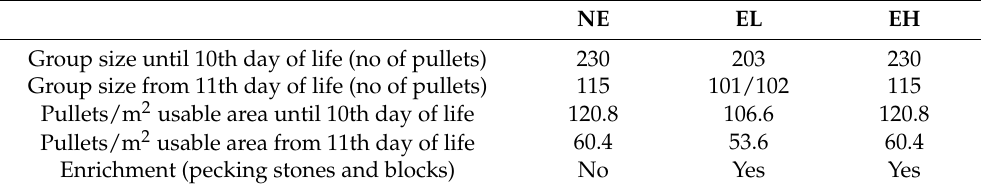
Table 1. Overview of the experimental groups NE (not enriched), EL (enriched, low stocking rate) and EH (enriched, high stocking rate): Stocking rates, enrichment, and group sizes. Half of each EG was placed in another compartment of the aviary on the 10th day of life, hence the reduced stocking rates from the 11th day of life onwards. Enrichment: Pecking stones and pecking blocks. NE EL EH Group size until 10th day of life (no of pullets) 230 203 230 Group size from 11th day of life (no of pullets) 115 101/102 115 Pullets/m 2 usable area until 10th day of life 120.8 106.6 120.8 Pullets/m 2 usable area from 11th day of life 60.4 53.6 60.4 Enrichment (pecking stones and blocks) No